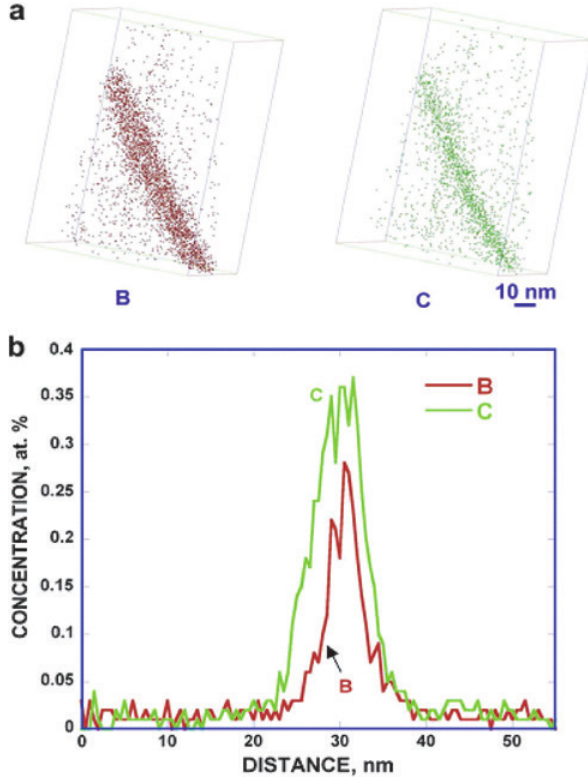
Fig. 1: (a) Atom maps for boron and carbon at a grain boundary, and (b) concentration profiles for boron and carbon through the matrix and grain boundary showing the segregation of boron and carbon at the grain boundary